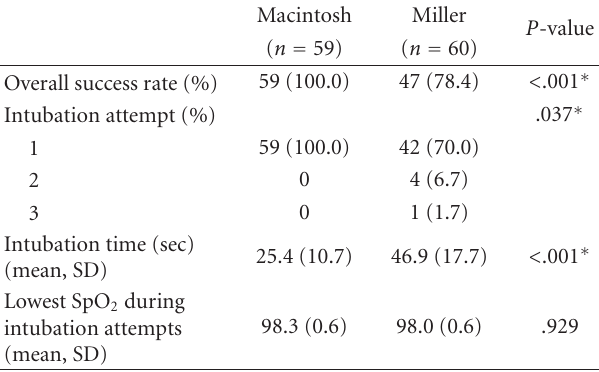
Table 2: Overall success rate, intubation attempt, intubation time, and the lowest SpO 2 during intubation